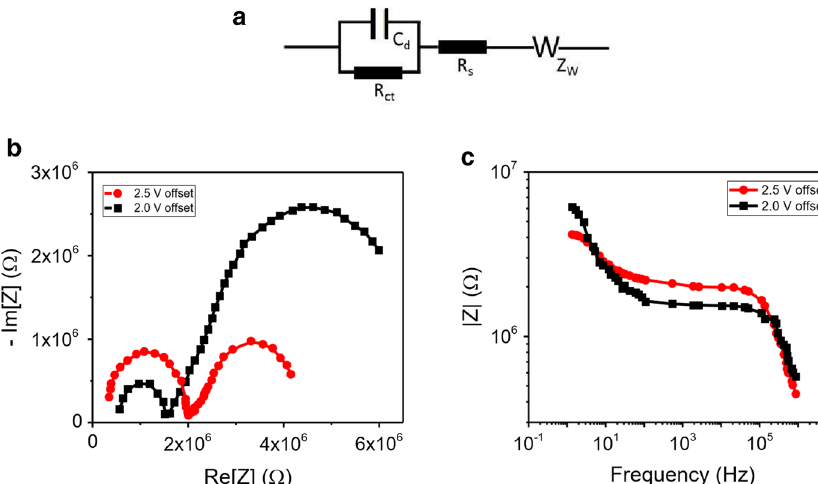
Fig. 1 Impedance characteri- zation during the growth. a Equivalent circuit model. b Nyquist plots of a process with 2.5 V offset and a process with 2.0 V offset. c Corresponding